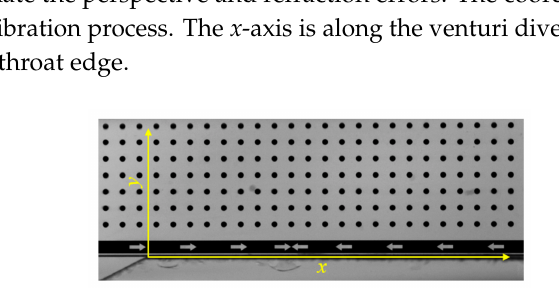
Figure 5. Calibration plate with a regular distribution of marks. The dot diameter is 0.33 mm, and the distance between dots is 1 mm. The coordinate system used is also